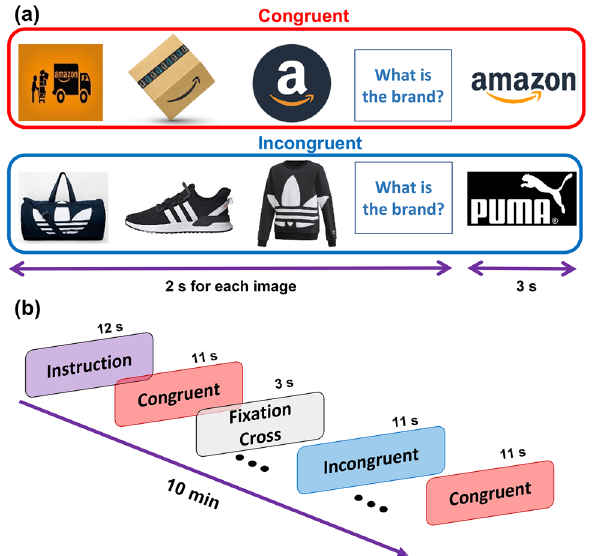
Figure 4. Example for stimuli and the task procedure. Panel ( a ) upper part shows an example for congruent set, where the last image (brand logo) matches the brand of the first three images. Panel ( a ) bottom part is an example for incongruent set where the last image and first three images do not match. Panel ( b ) shows the task procedure, which started with 12 s of instruction followed by congruent and incongruent image sets (randomized through the experiment). After each image set, there was a 3-s fixation